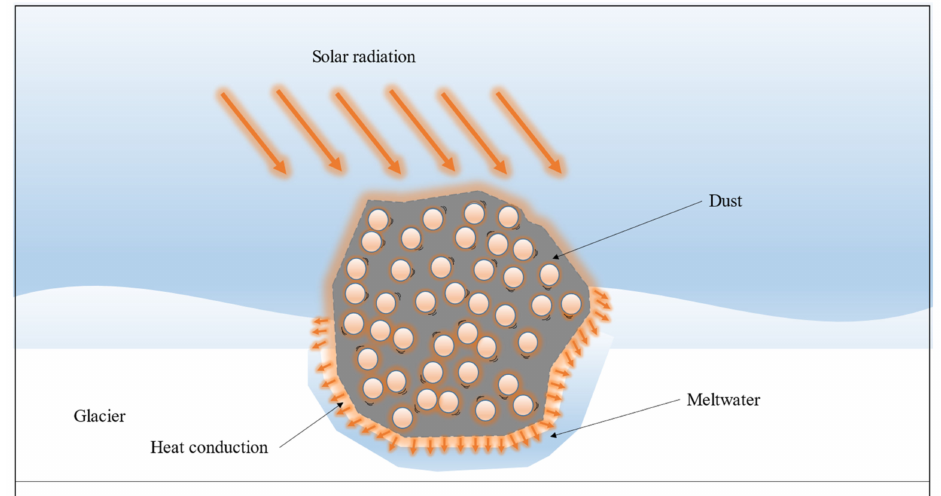
Figure 14. Energy transfer mechanism of mineral